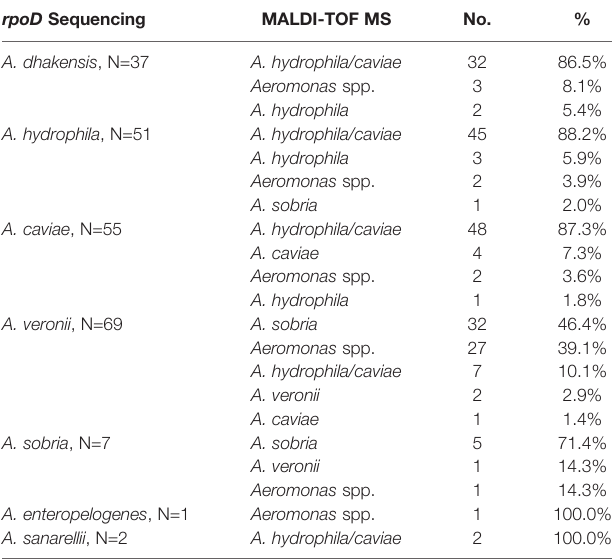
TABLE 2 | Comparison of rpoD sequencing with MALDI-TOF MS (V2.0). rpoD